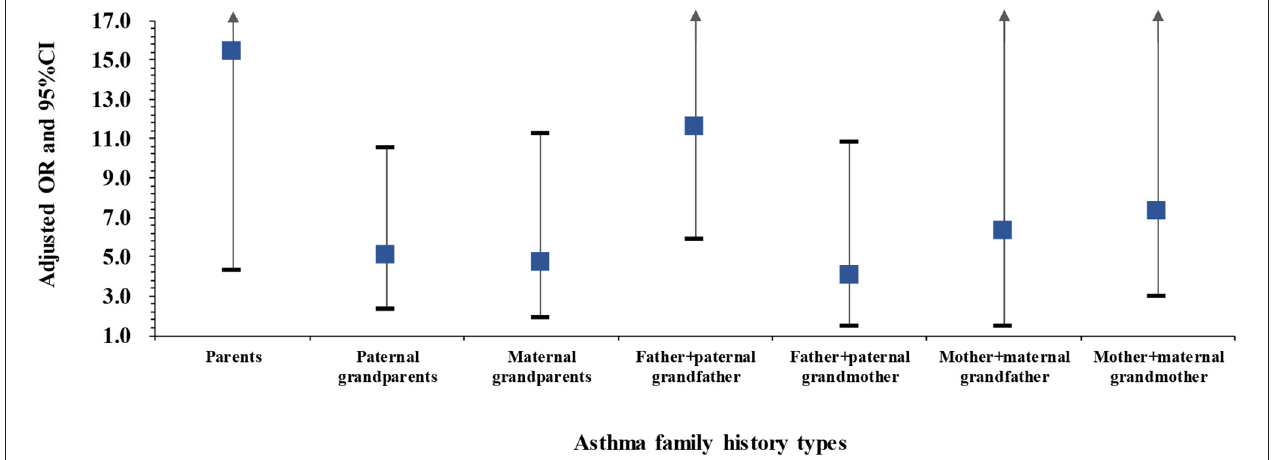
FIGURE 3 | Adjusted ORs and 95%CIs for asthma among children with two family members affected by asthma compared to those without any family member affected. Adjusted for passive smoke exposure, home coal use, pet kept and PM 2.5 exposure. Asthma cases: 5 cases with affected parents, 10 cases with paternal grandparents affected, 7 cases with maternal grandparents affected, 16 cases with father and paternal grandfather affected, 5 cases with father and paternal grandmother affected, 3 cases with mother and maternal grandfather affected, and 8 cases with mother and maternal grandmother affected.